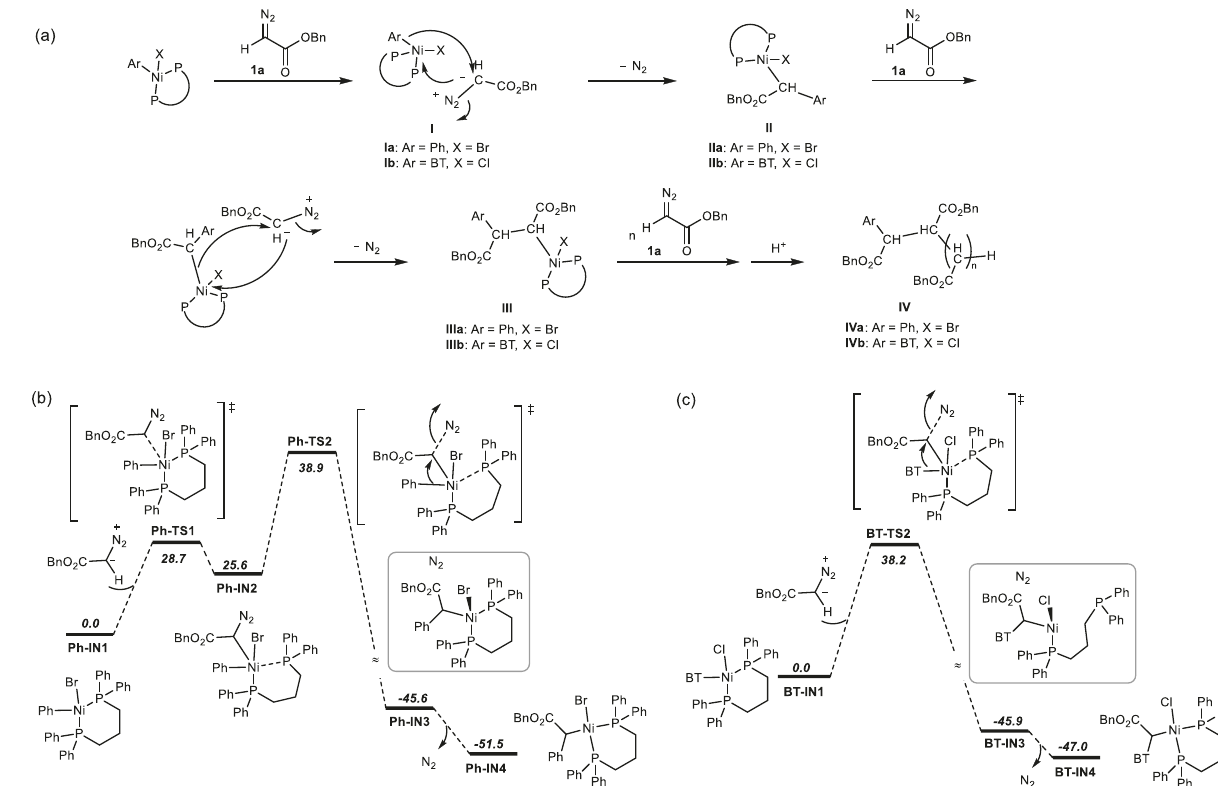
Fig. 8 Proposed polymerization mechanism. a Proposed mechanism for the Ni(II)-mediated diazoacetate polymerization of 1a , and preliminary density functional theory (DFT) calculations for the initiating reaction of 1a using Ph – Ni(dppp)Br ( b ) and BT – Ni(dppp)Cl